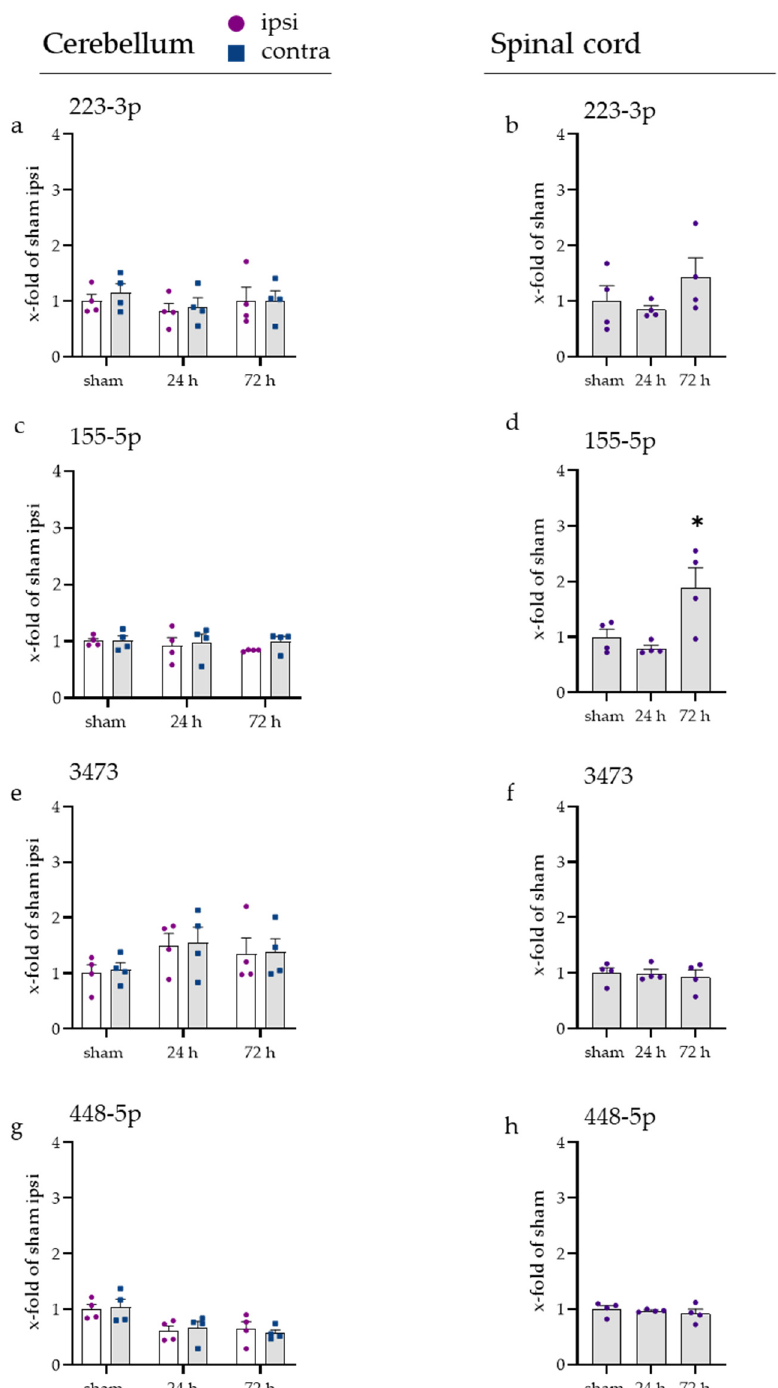
Figure A4. miRNA expression of the cerebellum and spinal cord after 24 h and 72 h following tMCAo. ( a , e ) miRNA levels of miR-223-3p, ( b , f ) miR-155-5p, ( c , g ) miR-3473, and ( d , h ) miR-448-5p. The graphs show the individual values for (purple) ipsi and (blue) contra and the mean in bars. Data were compared to the sham ipsi group and pictured with the x-fold expression of this group ± SEM. (*) shows a significant difference between the ipsilateral side and sham ipsi where (§) shows a sig- nificant difference between the contralateral side and sham contra. (#) comparison as indicated.